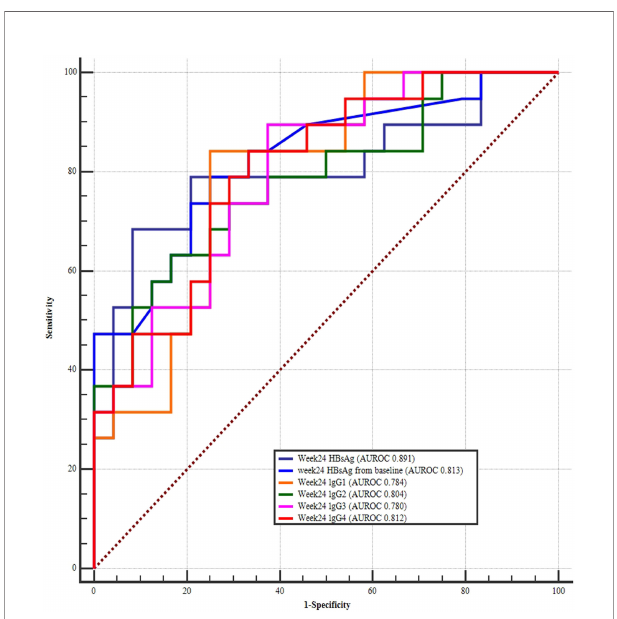
FIGURE 5 | ROC curves of week 24 HBsAg, week 24 HBsAg change from baseline, week 24 IgG1, IgG2, IgG3, and IgG4 for predicting HBsAg clearance. The largest area under the curve was week 24 HBsAg (AUROC 0.891), followed by HBsAg change from baseline (AUROC 0.813), week 24 lgG4 (AUROC 0.812), week 24 lgG2 (AUROC 0.804), week24 lgG1 (AUROC 0.784), and week 24 lgG3 levels (AUROC 0.780).